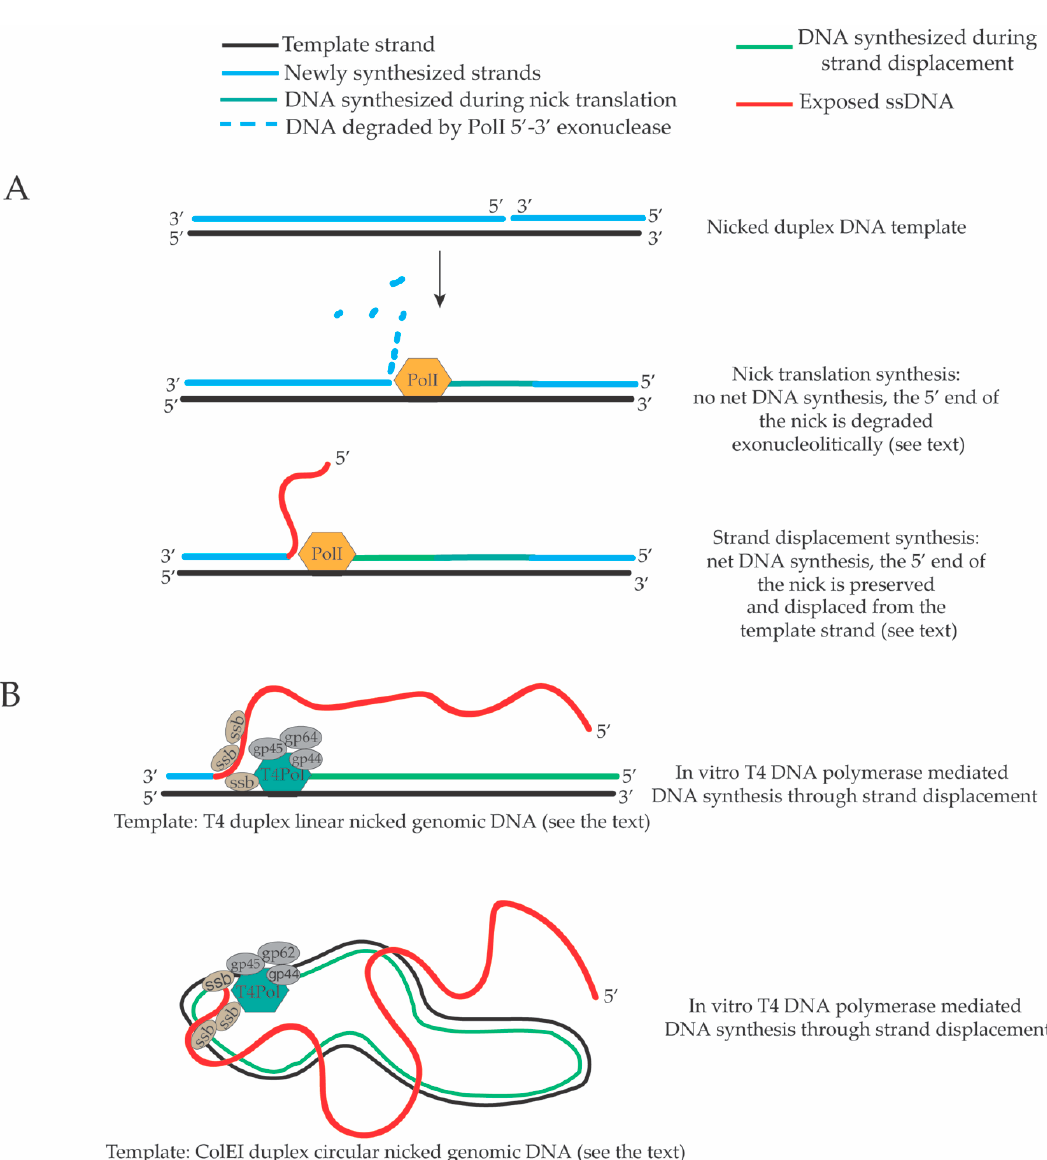
Figure 3. DNA synthesis through strand displacement in bacterial and bacteriophage DNA polymerases. ( A ) E. coli DNA polymerase I (PolI) can carry out DNA synthesis through strand displacement on